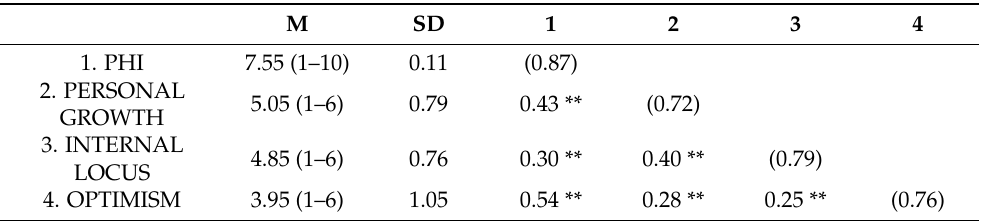
Table 2. Means, standard deviations, and correlations (Pearson’s r) of G2 (2020). M SD 1 2 3 4 1. PHI 7.24 (1–10) 0.12 (0.88) 2. PERSONAL